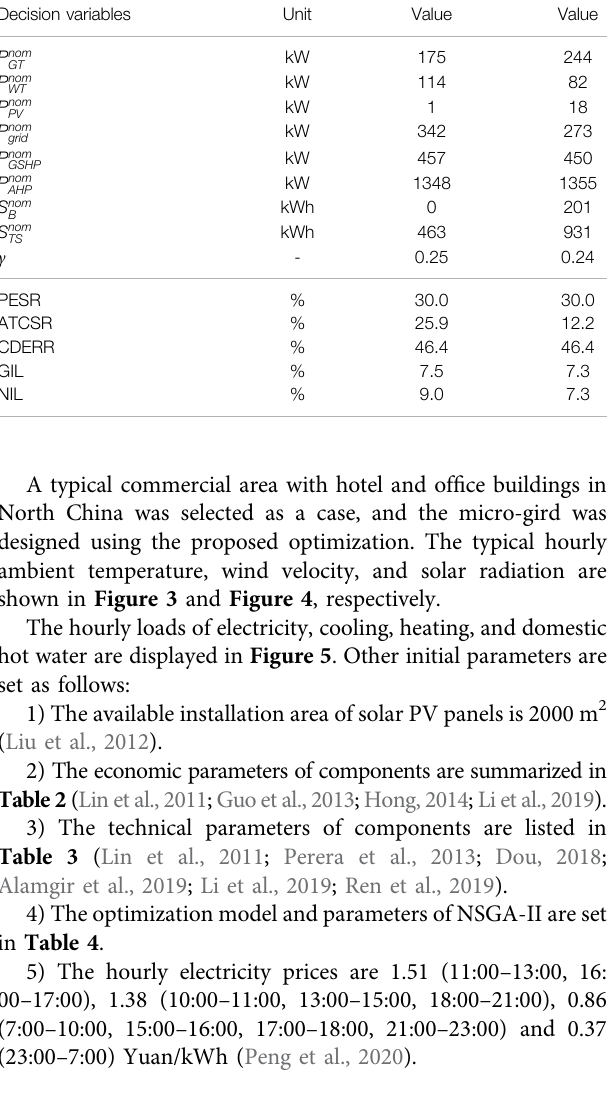
TABLE 6 | Typical system con fi gurations and performances in different optimization objectives Optimization